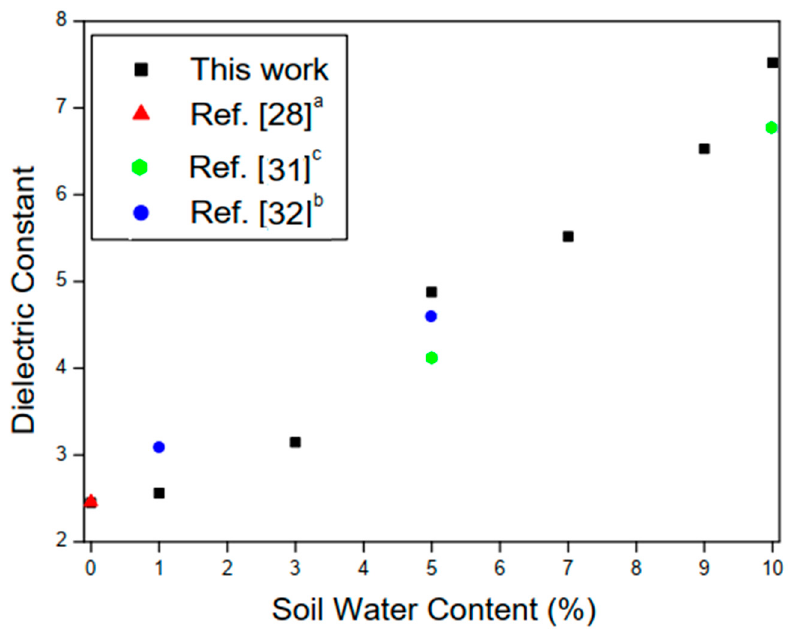
Figure 9. Measured results for different SWC (%) with quartz sand. a Soil sample obtained in the region of Banat in north-east of Serbia. b The values shown are the mean value of those obtained from measurements. c From Energy Dispersive X-ray (EDX) analysis, the sand soil sample is composed of 11.5% of Carbon, 28.1% Silicon, 0.1% Magnesium, 0.7% Iron, and 53% of Oxygen.